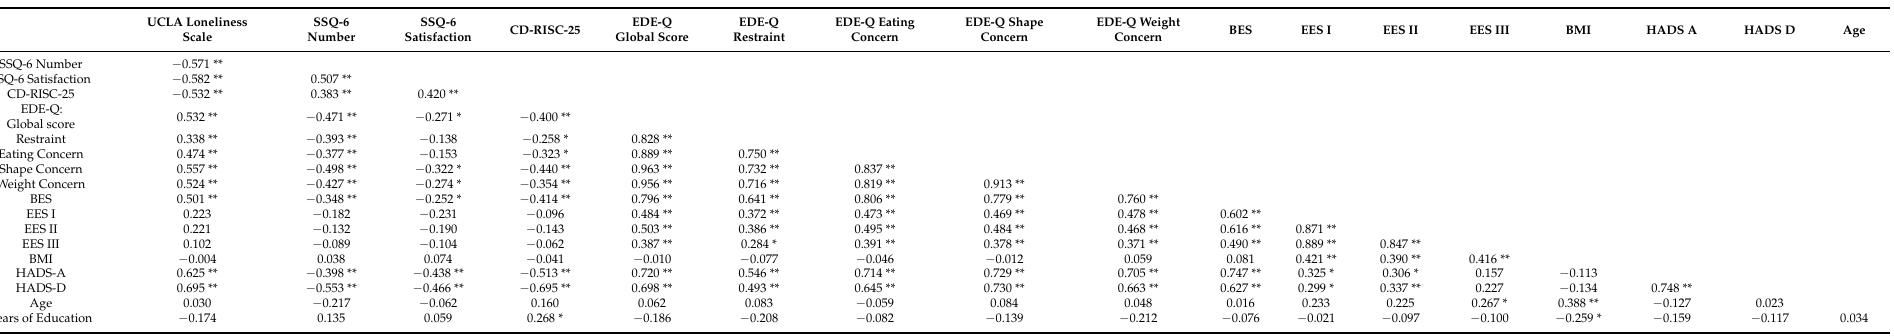
Table A1. Correlation matrix for the variables: loneliness, social support, eating disorder symptoms/features, resilience, binge eating, emotional eating, BMI, anxiety and depression levels, age, and years of education for the total sample.